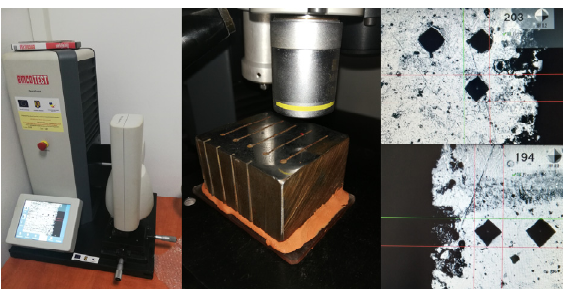
Figure 9. Vickers Microhardness Test